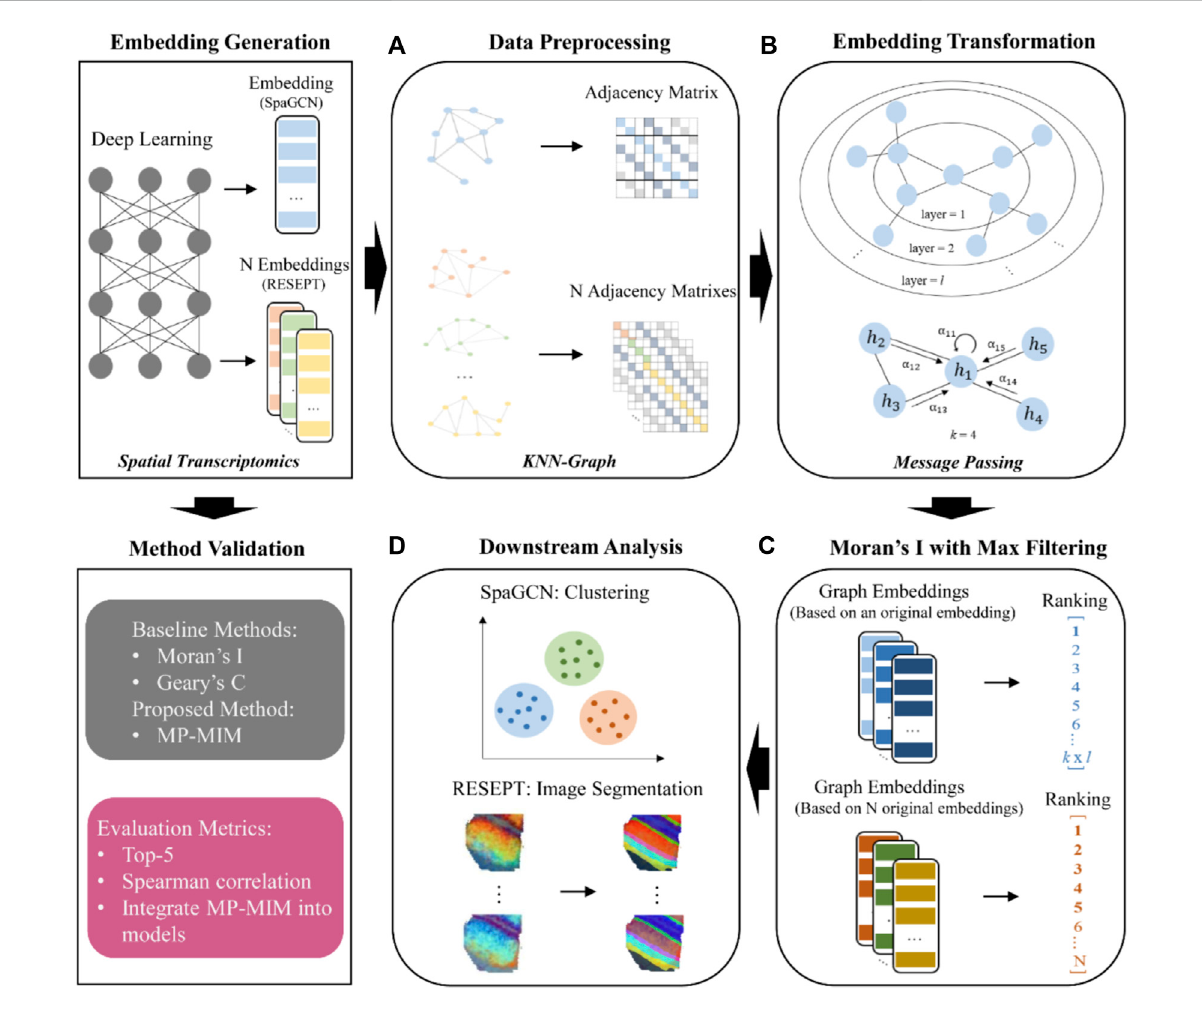
FIGURE 1 Work fl owof theproposedmethod MP-MIMandmethodvalidation. MP-MIMtakes theembeddinggeneratedfrom thedeep learningmodel by using spatial transcriptomics data as the input. (A) , (B) , (C), and (D) show theprocess starting from converting the input into the KNN graph. Message passing based on graph convolution transforms the original embedding with the KNN-graph structure to graph embedding. Moran ’ s I evaluated the multiple transformed embeddings with maximum fi ltering according to all the dimensions of each embedding. Finally, the graph embeddings and quality ranking are the output for the downstream analysis in their respective models. The method validation panel shows the baseline comparison methods and the speci fi c evaluation